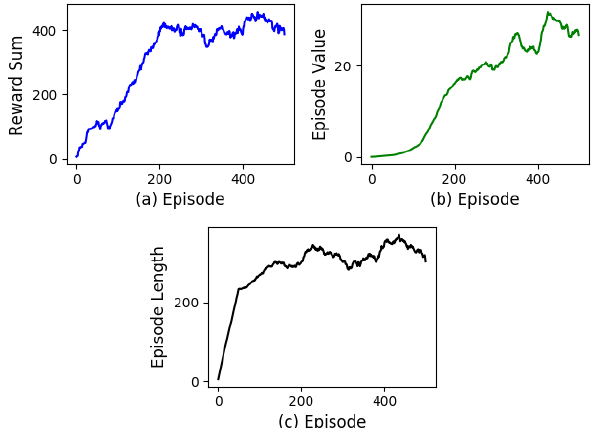
Figure13. Inthesefigures,thehorizontalaxesshowtheepisodeandvertical axis show (a) the average reward, (b) the state value, and (c) the average amount of time steps by episode. One thousand episodes take eight hours approximately.